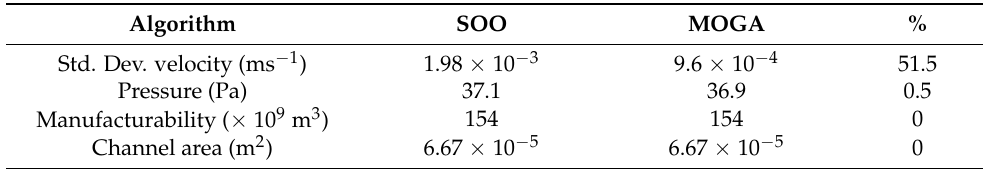
Table 4. Comparison of optimization algorithms.